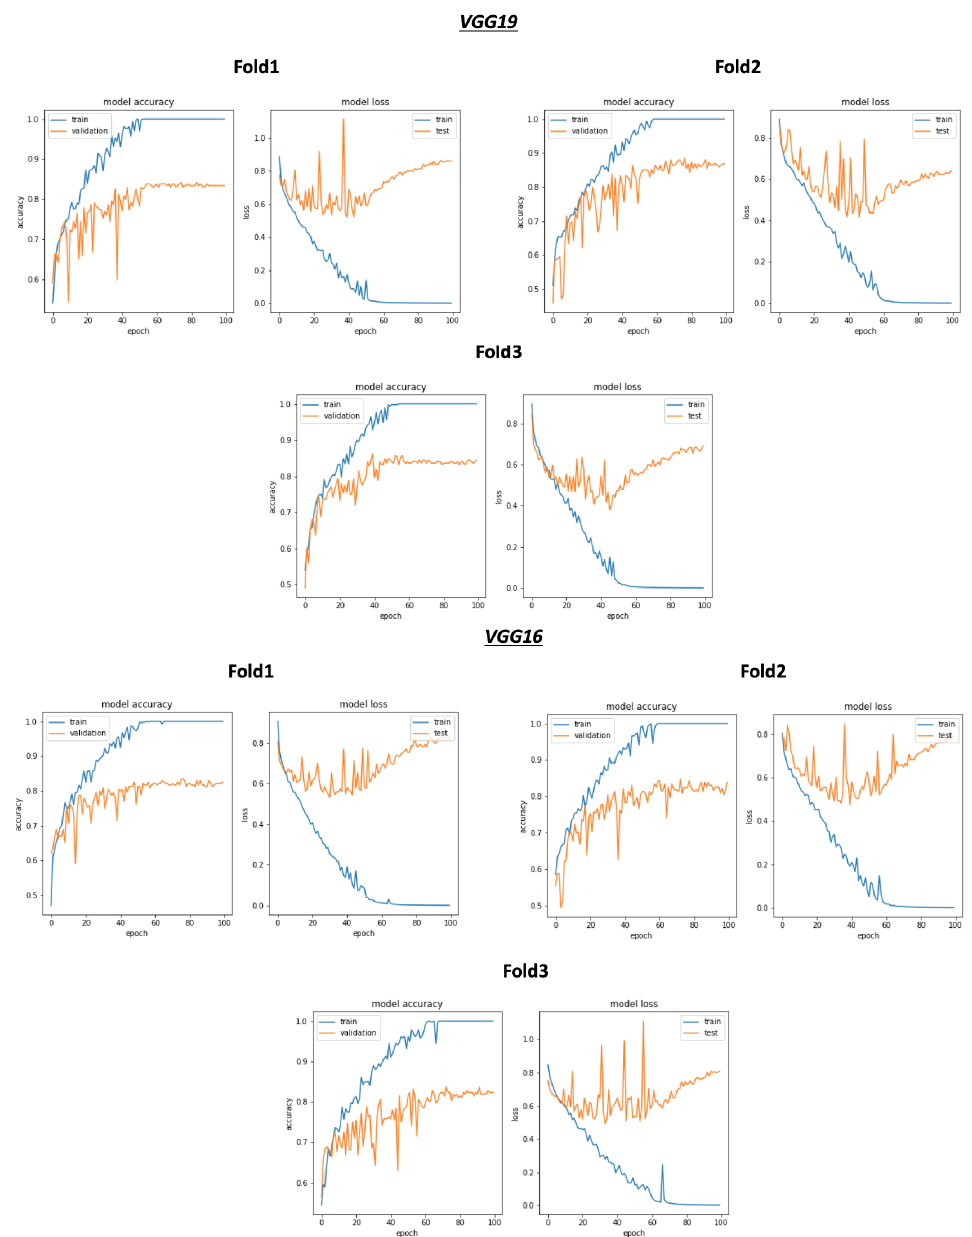
Figure 10. Overview of CNN VGG16-VGG19 validation accuracy curve with selection